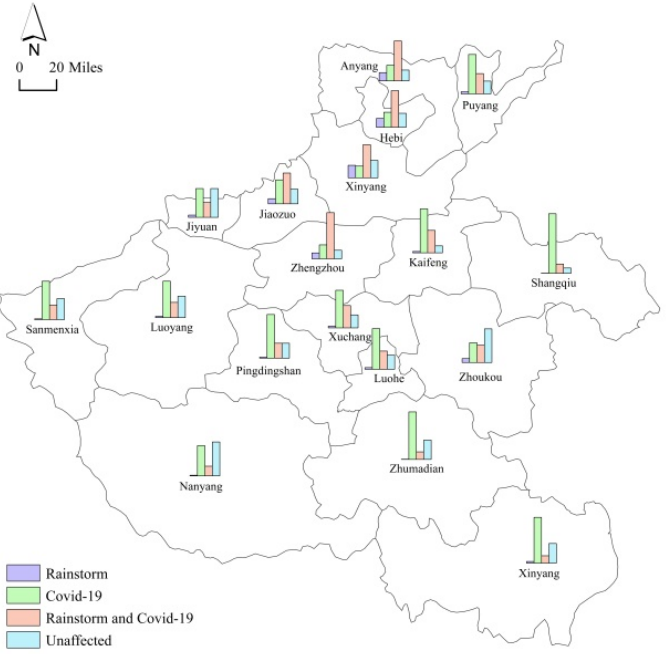
Figure 11. The YoY growth rate of total retail sales of consumer goods.